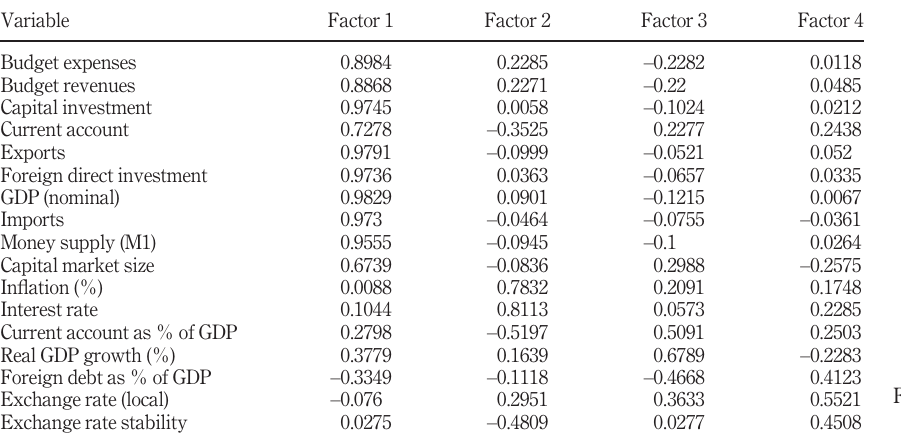
Table V. Factors extracted